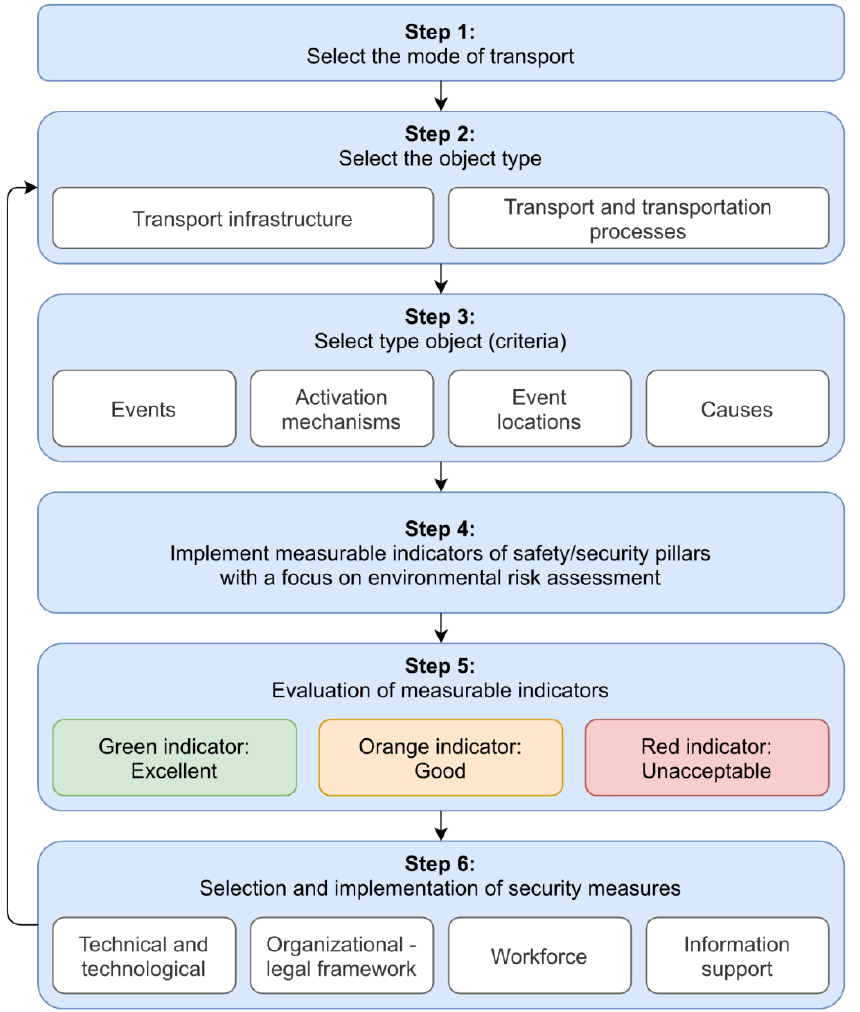
Figure 4. Environmental risk assessment procedure in transport.